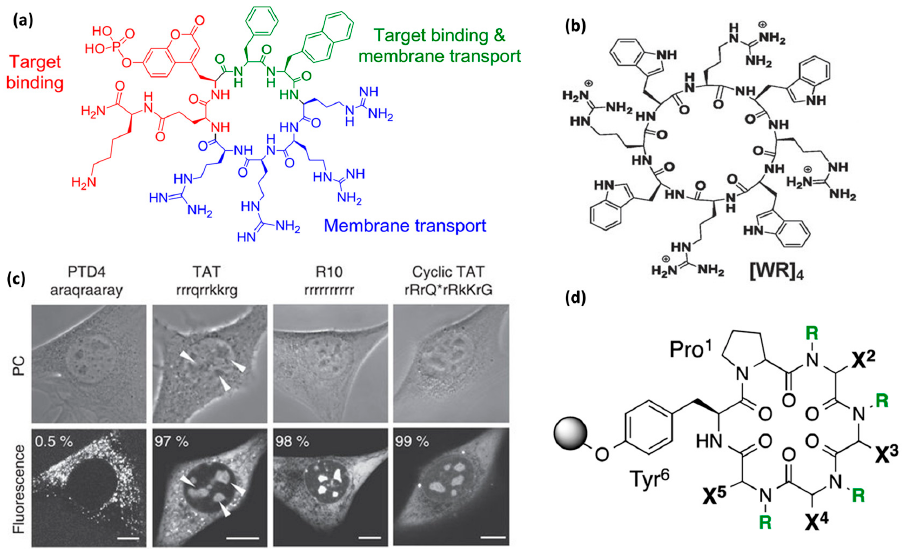
Figure 8. ( a ) Example of the design of cyclic CPPs containing different domains, such as repeating arginine units, a hydrophobic region to facilitate membrane interactions, and a target binding region (reprinted with permission from reference [140], Copyright © 2013, American Chemical Society); ( b ) Chemical structure of a different example of cyclic CPP design, based on alternating arginine with tryptophan residues, with the [WR] 4 candidate showing the best performance, used with permission from reference [136] (Copyright © 2011 Wiley); ( c ) Phase contrast and confocal images of live-cell transduction ability of fluorescently labeled CPPs: PTD4, Tat, R 10 and cyclic Tat were internalized into living mouse myoblast cells with different efficiency, cyclic Tat being the most efficient (taken from reference [21], Copyright © 2011, Nature Publishing Group); ( d ) Generic structure of the library of geometrically diverse cyclic hexapeptides (based on L - and D -stereoisomers), reprinted with permission from reference [137], Copyright © 2015, American Chemical Society.